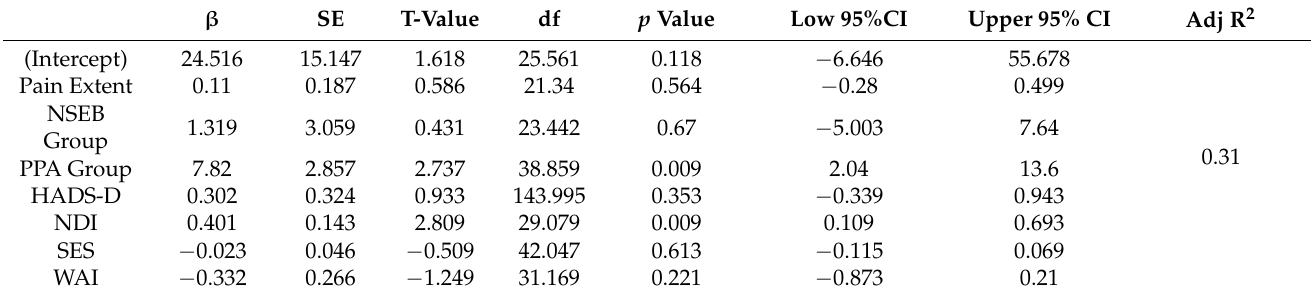
Table 5. Adjusted associations between baseline pain extent to 1 year NDI